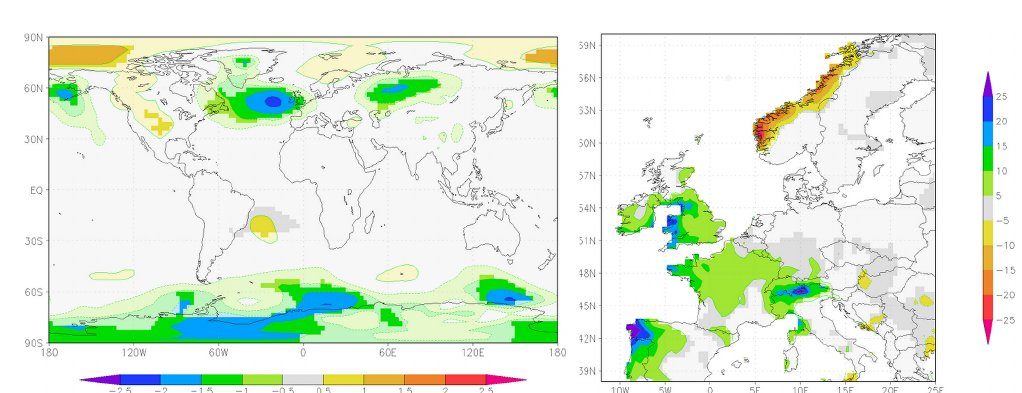
Figure 10. Left panel: near-global PMSL anomalies (hPa) in the winter half-year for TSI values in the highest 20% of its winter half-year distribution over 1948–2011. Earlier years not used as the solar cycle mostly varied at an averaged reduced level of total solar radiation. Right panel: rainfall anomalies (mmmonth − 1 ) over the UK and nearby Europe. Areas significant at the 5% level are darker coloured.